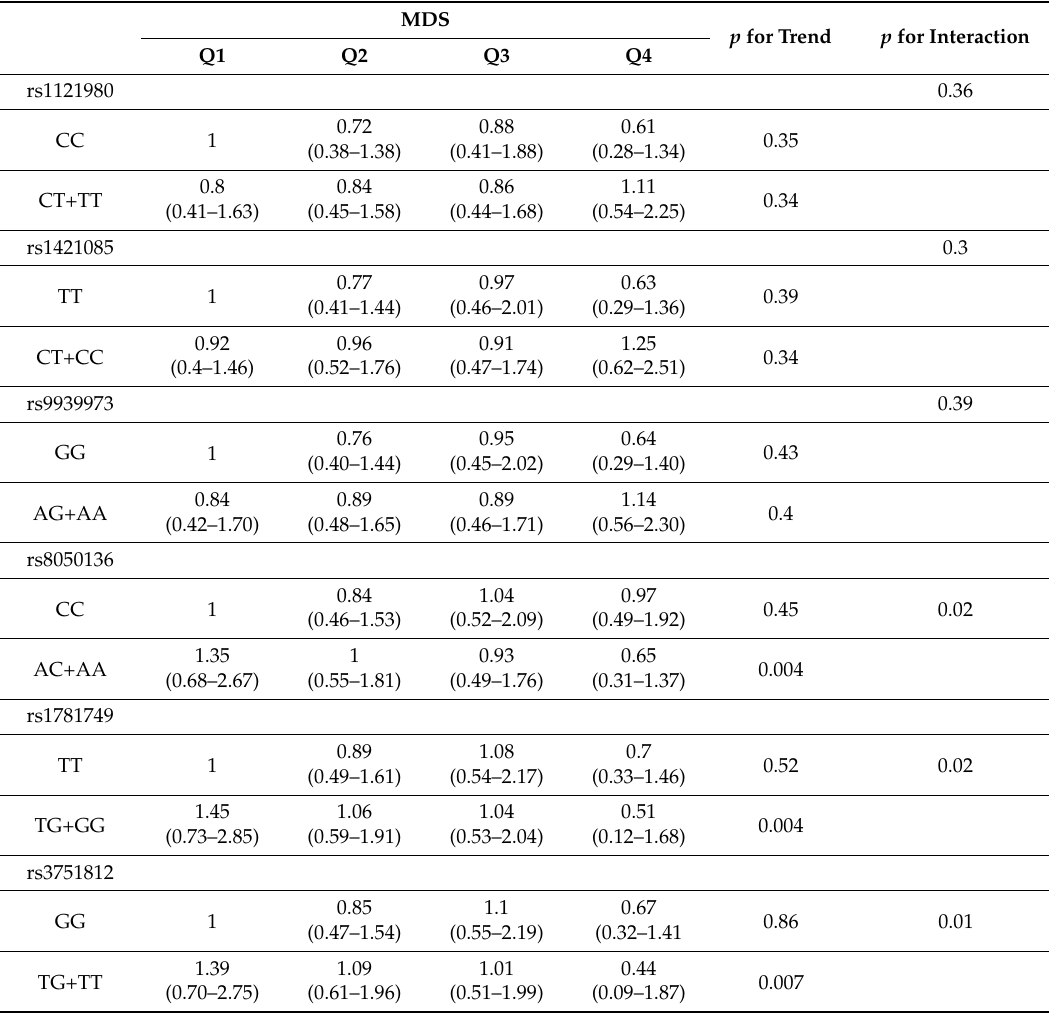
Table 4. Adjusted ORs (95%CI) a for abdominal obesity according to quartiles of MDS by FTO SNP genotypes (Tehran Lipid and Glucose Study).